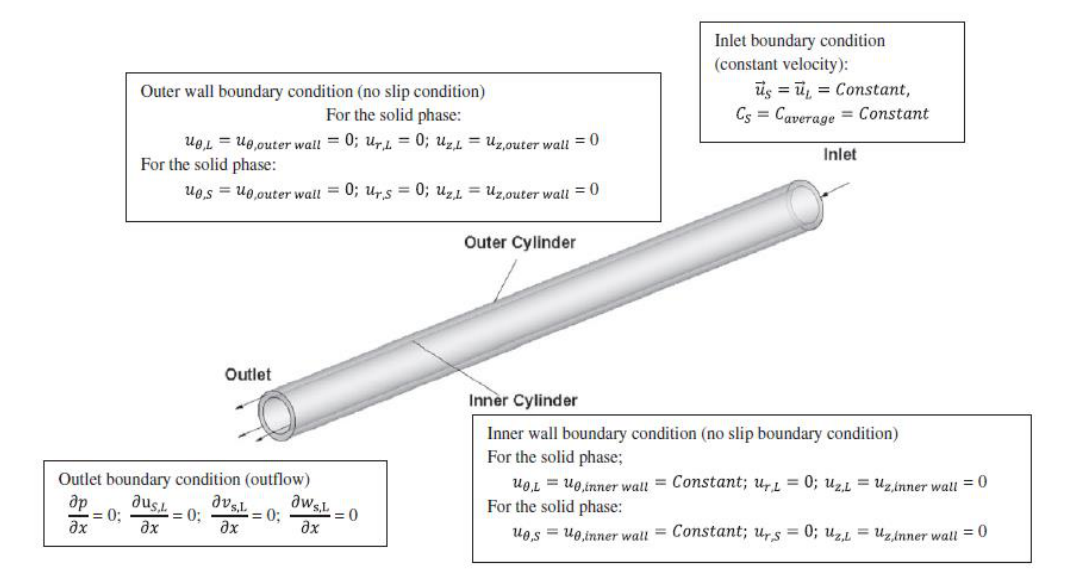
Figure 1. Geometry and boundary